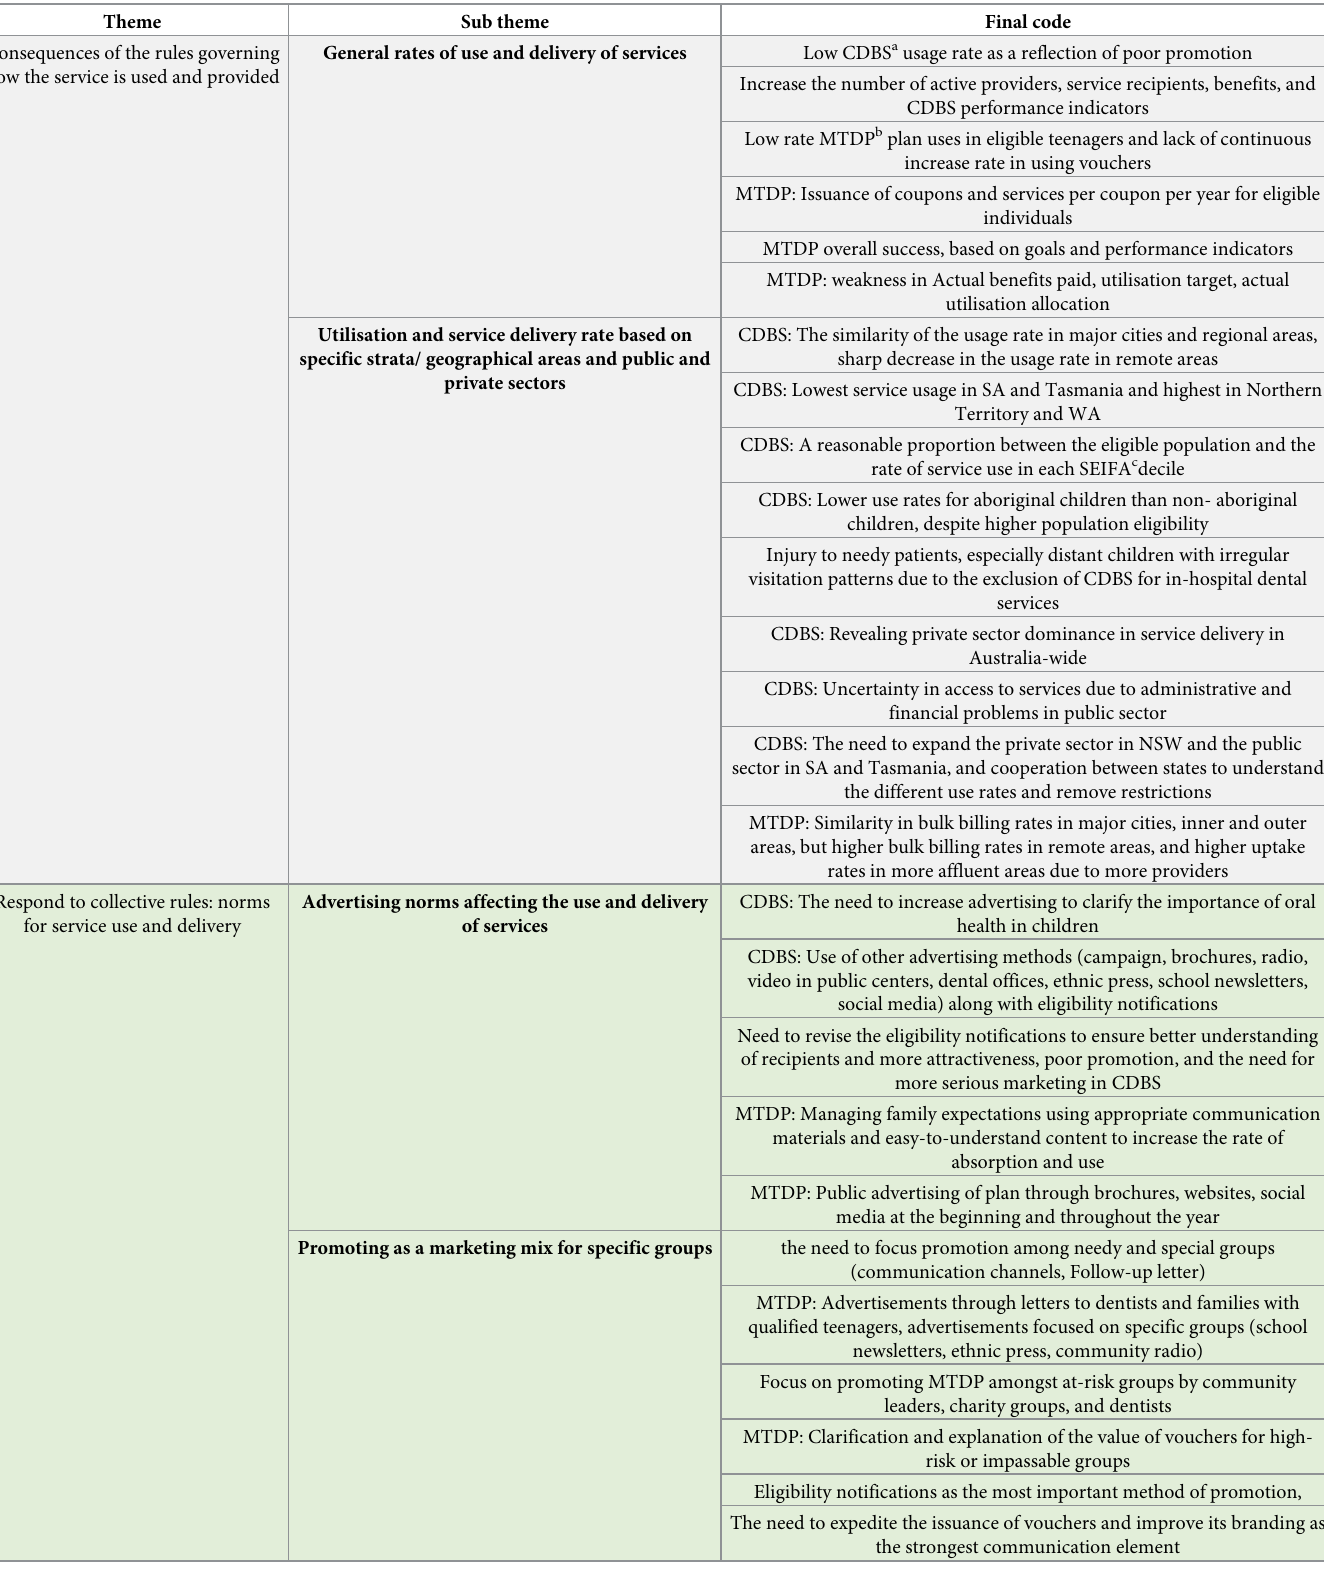
Table 1. The main and sub-themes related to operational